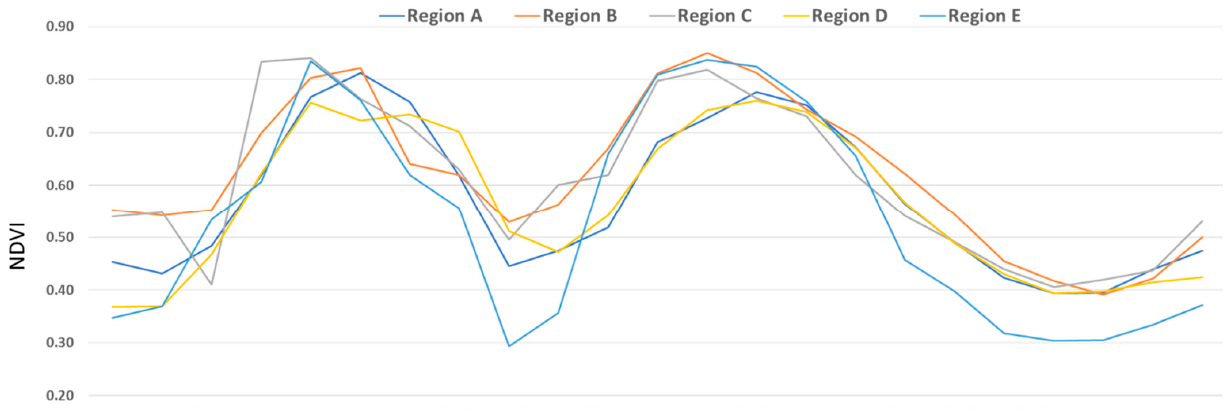
Figure 9. Spatial variability of the mean annual NDVI time series (between mid-2012 and mid-2019)